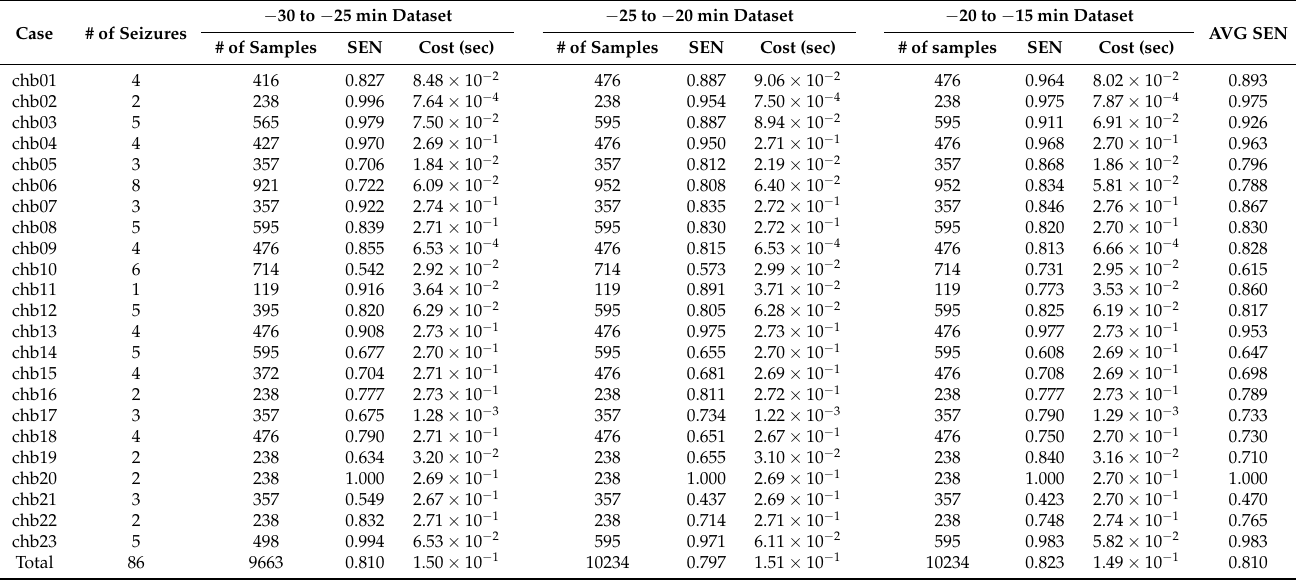
Table 5. Evaluation Results of extended pre-ictal data using optimal models. The extended data 15 to 30 min before the onset is divided into three datasets. These three datasets with same number of seizures are − 30 to − 25 min dataset, − 25 to − 20 min dataset and − 20 to − 15 min dataset. # of samples: Number of 5-s segments used for prediction. SEN: The percentage of the samples that are correctly predicted as pre-ictal state. Cost: Average time to predict a sample. AVG SEN: Average sensitivity of these three dataset on each